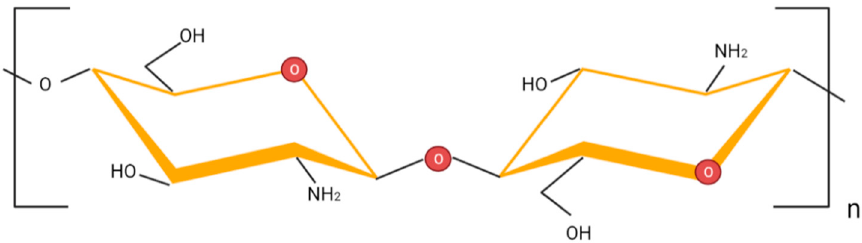
Figure 1. Chemical structure of chitosan.